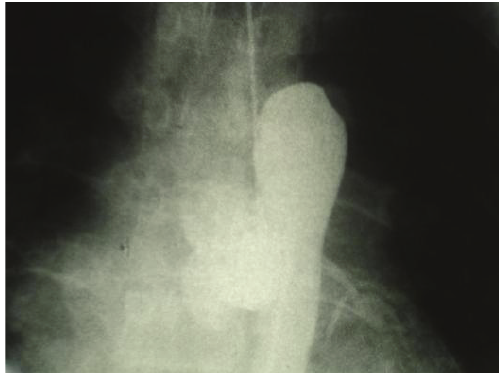
Figure 3: Double brachiocephalic trunk.